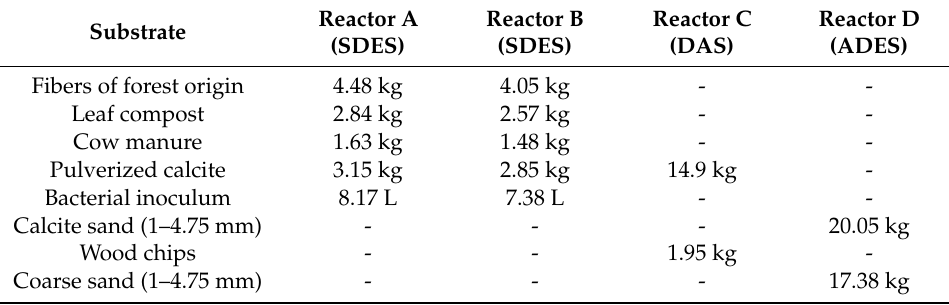
Table 1. Prototype reactive mixture composition 1 .